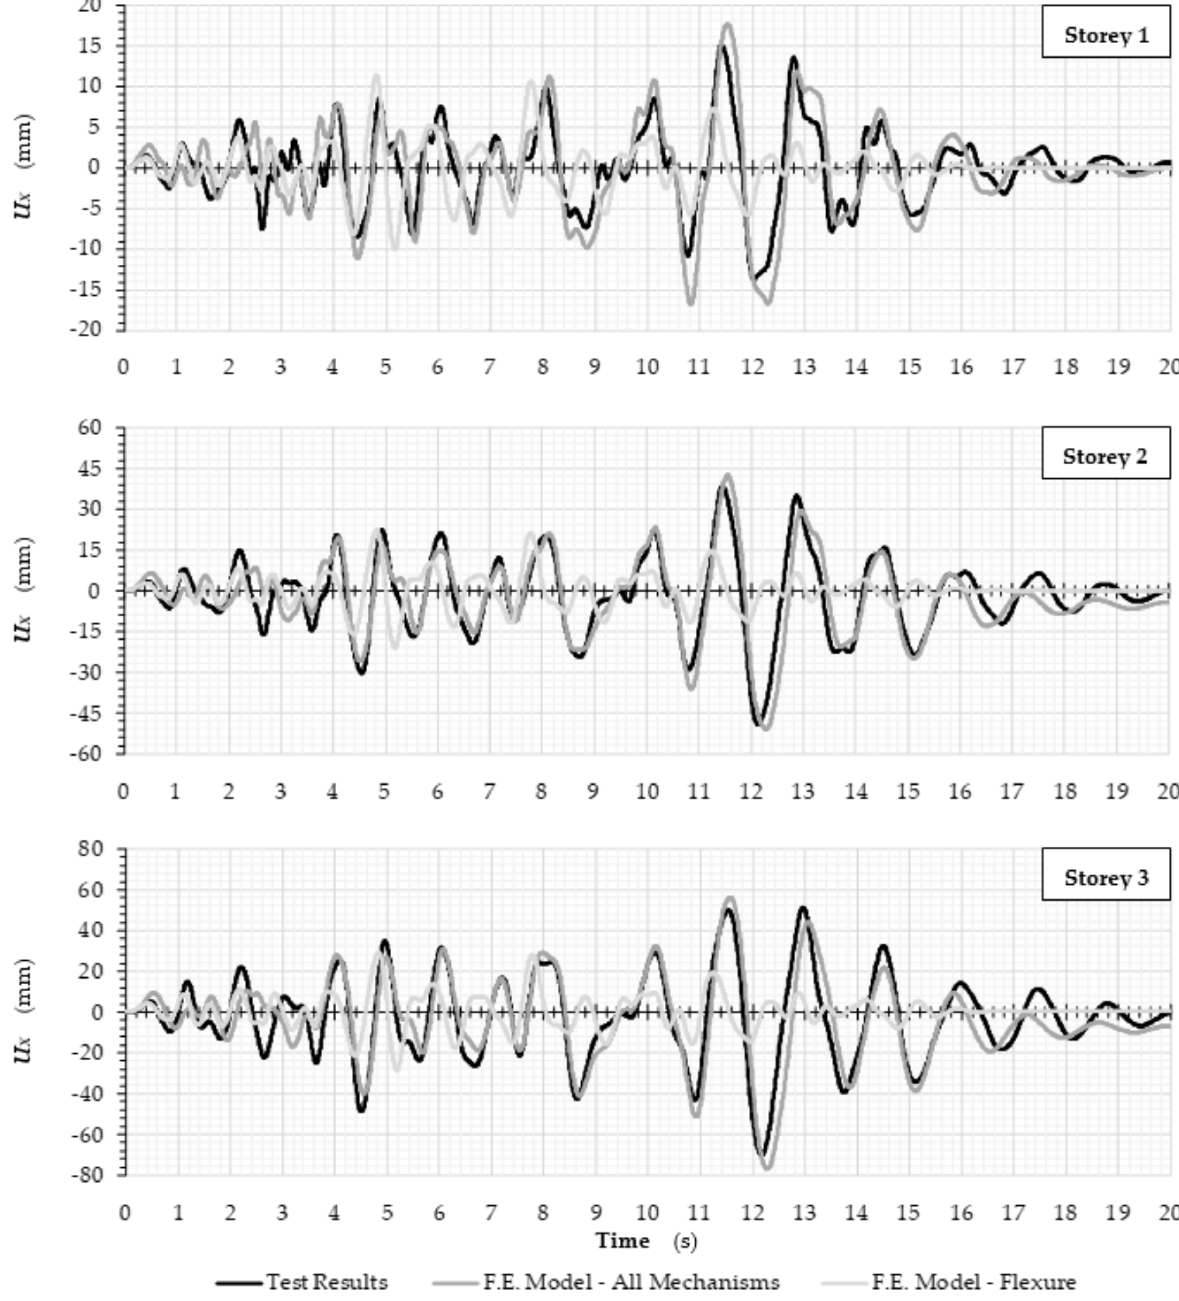
Figure 10. Comparison of the horizontal displacements in the X -plan direction measured at the SPEAR building during the s11 earthquake case and the corresponding response estimated from a dynamic analysis using two different FE building